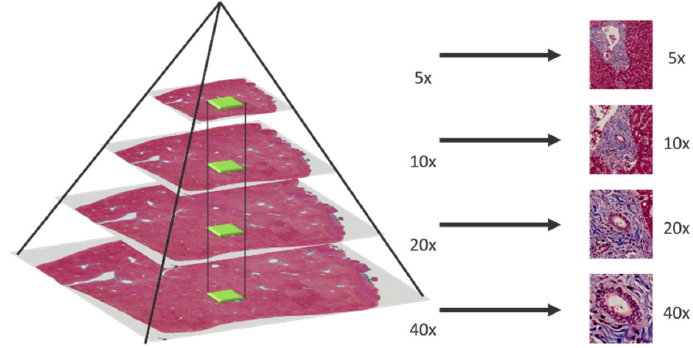
Figure 4. The central crop method to align different magnification feature maps.